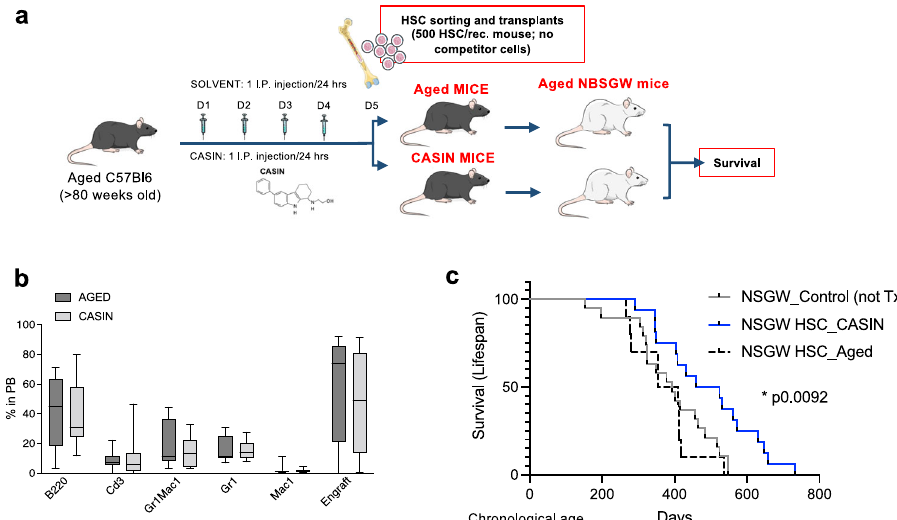
Fig. 6 Blood stem cells from CASIN mice extend murine median and maximum lifespan. a Experimental design for non-competitive transplants in not-preconditioned immunocompromised aged mice. 500 sorted HSCs were transplanted without competitor cells in aged NBGSW mice. b Flow cytometry quanti fi cation of peripheral blood pro fi le at 4 months after transplantation of aged NBSGW recipient mice. (Aged, n = 7; CASIN, n = 9). Columns are mean ±SE. c Survival after Tx and overall lifespan of NBGSW mice. (Aged, n = 10; CASIN, n = 16; Not transplanted, n = 19). Survival analysis with Mantel Cox test. Source data are provided as a Source Data fi le. Mouse cartoon: CreativeBucket:stock.adobe.com. Bone and cells cartoon: